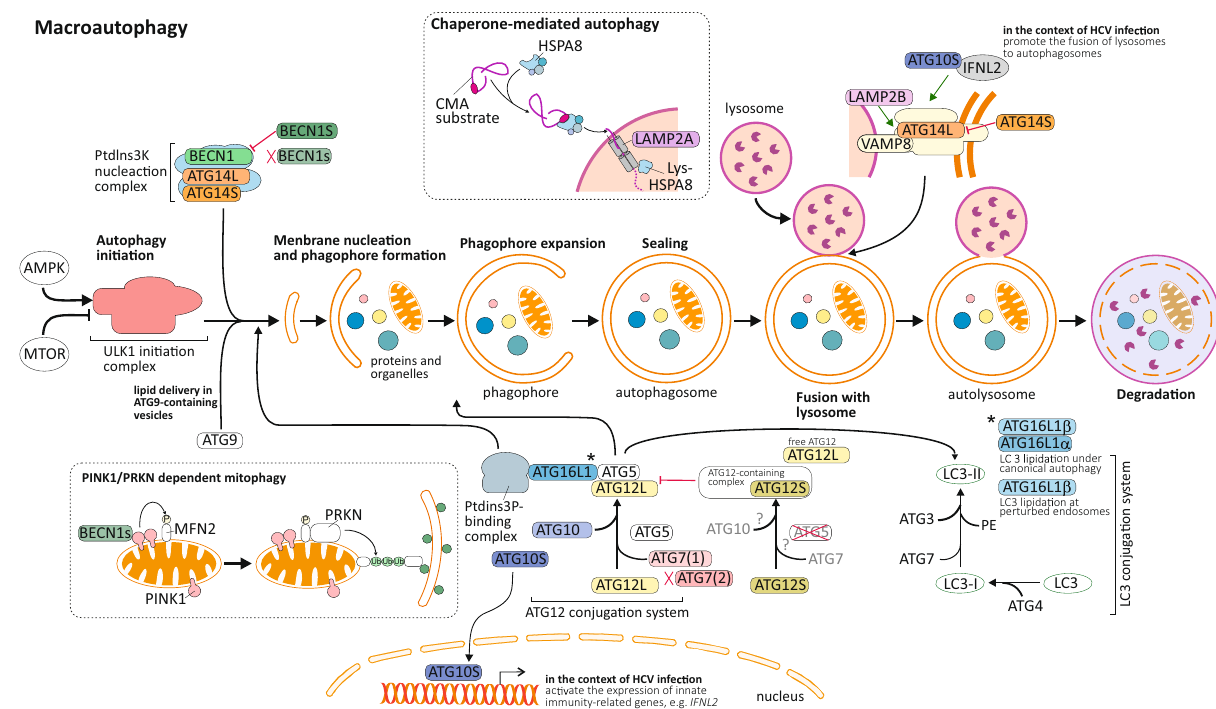
Fig. 3 Impact of alternatively spliced autophagy isoforms on autophagic process. BECN1 as a subunit of the class III PtdIns3K nucleation complex contributes to autophagy initiation. A splice isoform, BECN1S, acts a negative regulator of autophagy induction. An additional splice variant, BECN1s, lacks function in the initiation of autophagy but supports PINK1- and PRKN/PARKIN-dependent mitophagy. A long and a short (lacking the homodimerization domain) splice isoform of ATG14 are reported. Whereas both isoforms can promote autophagy induction, they exert opposite effects on the regulation of autophagosome-lysosome fusion, with ATG14L endorsing but ATG14S restraining the formation of autolysosomes. Multiple components of the ATG12- conjugation system present splice isoforms. The presence of ATG12S, a short isoform of ATG12 which appears to be lacking the ability to form a covalent complex with ATG5, leads to the appearance of additional ATG12-containing complexes, beyond the ATG12 – ATG5 complex, and the occurrence of free ATG12L, as well as reduced LC3 conjugation and autophagy fl ux. The ATG16L1 splice isoforms α and β , both allow the recruitment of the ATG12 – ATG5 conjugate to the phagophore leading to the subsequent conjugation of LC3 proteins. The ATG16L1 β isoform, with its unique lipid-binding region domain, also exerts an additional effect on LC3 lipidation at perturbed endosomes. In the context of hepatitis C virus (HCV) infection, a short ATG10 isoform, nuclear ATG10S, acting as a transcription factor, activates IFNL2/IL28A gene expression; IFNL2 protein in turn together with cytoplasmic ATG12S enhances autophagosome-lysosome fusion. ATG7(2), a short splice isoform of the canonical ATG7(1), lacks the ability to bind to LC3 and promote its lipidation. LAMP2 codes for splice variants that differ in their transmembrane and cytosolic regions within the C terminus region and exert distinct functions. Whereas LAMP2A controls the translocation of chaperone-mediated autophagy substrates across the lysosomal membrane, LAMP2B and LAMP2C promote the formation of autolysosomes or contribute to selective types of